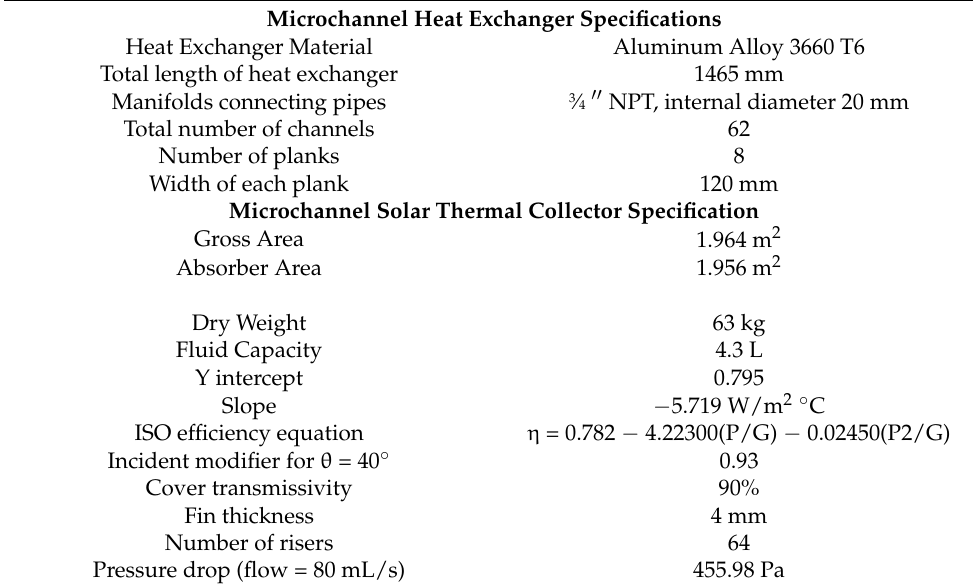
Table 3. Microchannel Heat Exchanger Specifications and Microchannel Solar Thermal Collector Spec-